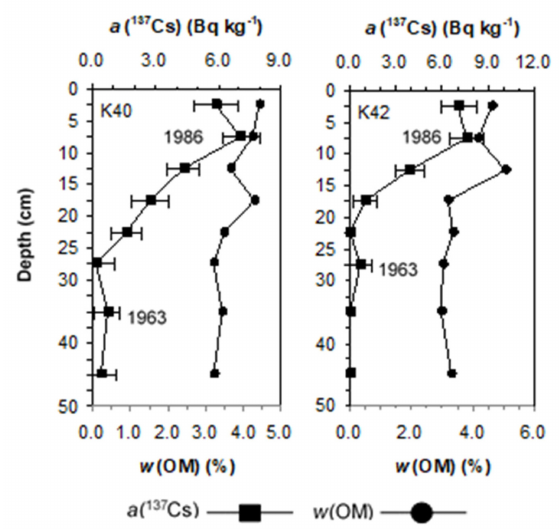
Figure 2. Undisturbed 137 Cs massic activity profiles with peaks representing sediment surfaces of 1963 and 1986 and organic matter mass fraction profiles. Measurement uncertainties are expressed with k = 2 for normal distribution.